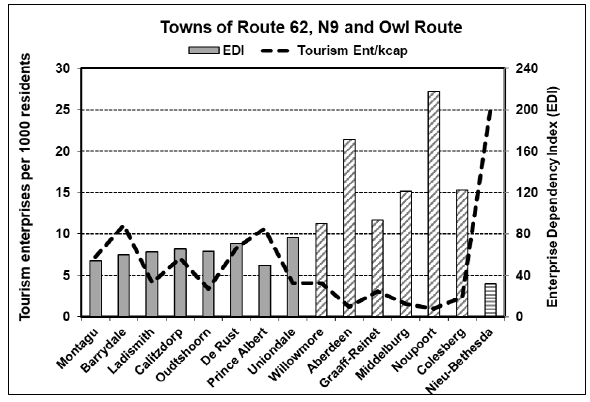
Figure 7: Comparison of the tourism sector strength (tourism enterprises per 1000 residents and abbreviated as Tourism Ent/kcap) and enterprise dependency indices (EDI) of the towns of Route 62 (even coloured), of the N9 national road (diagonal stripes) and the Owl Route (Nieu-Bethesda, horizontal stripes).